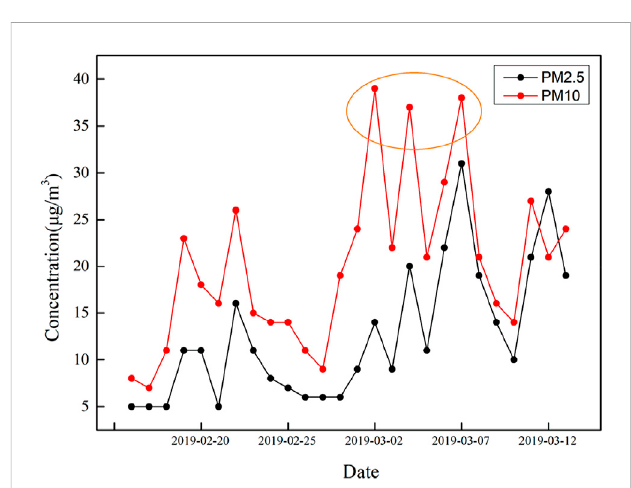
FIGURE 10 ThedailyaveragevaluesofPM2.5andPM10inAltayregionfromthe endofFebruarytothebeginningofMarch2019.Thedatacomefromthe China Meteorological Administration